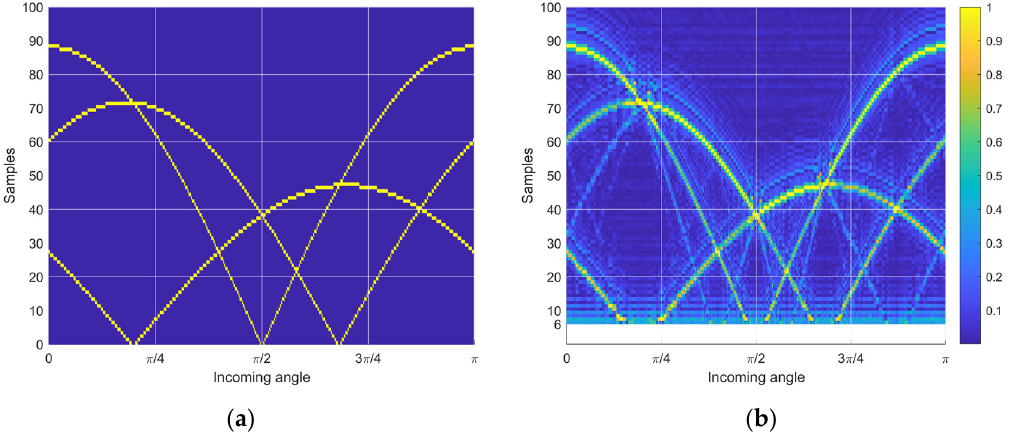
Figure 8. Time delay distribution from optimal similarity configuration. ( a ) Theoretical time delay distribution. ( b ) Estimated time delay distribution with nonparametric HD.